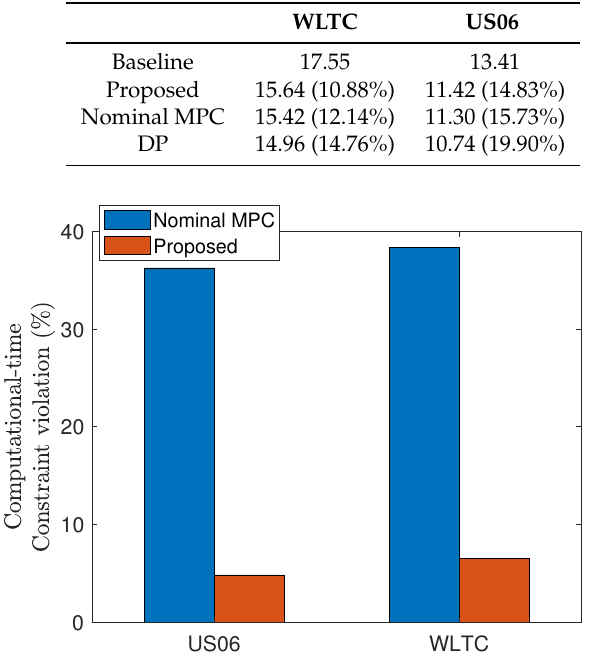
Table 4. ∆ SOC obtained by different optimized speed trajectories (the values in parentheses describe the improvements compared to the baseline).